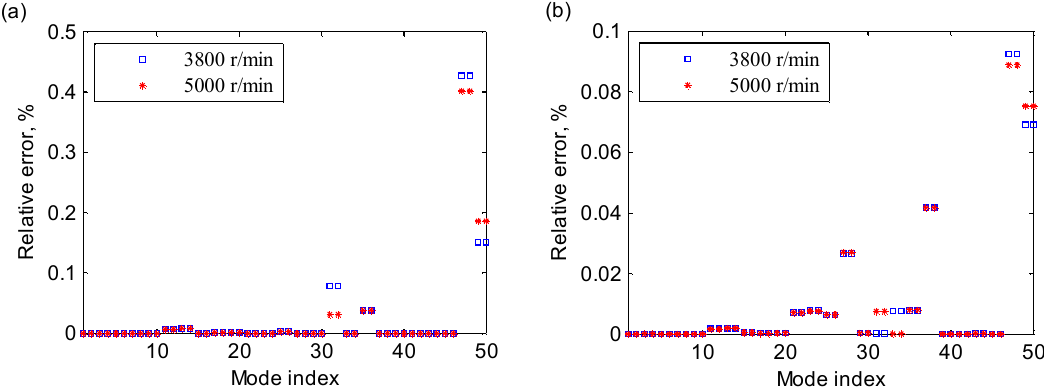
Figure 4. The relative errors of the first 50 damped eigenvalues of the anisotropic rotor-bearing system with a 20-mm crack at the speeds of 3800 and 5000 r / min: ( a ) the real parts, ( b ) the imaginary parts.